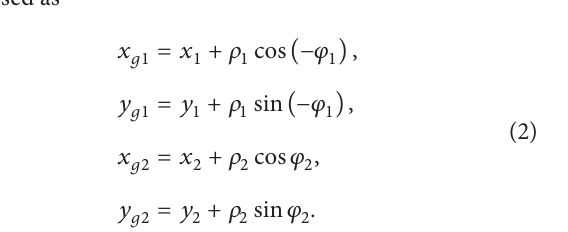
fixed in bearing chock, and inner ring is fixed in shaft. The balls are uniformly distributed between outer ring and inner ring. V 𝑗 and V 𝑜𝑗 are velocities at the contact points between the rolling ball and outer/inner ring, which can be expressed